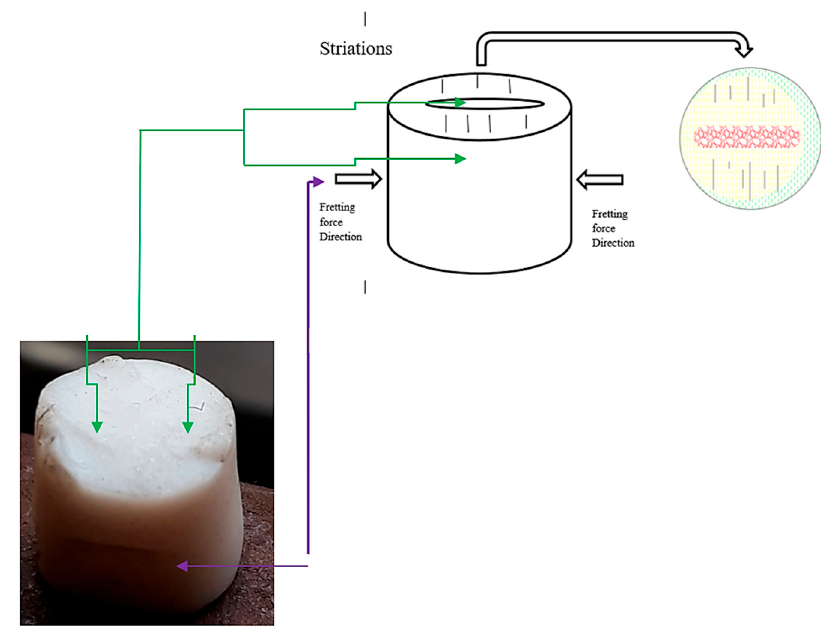
Figure 9. Schematic demonstration of fracture failure.